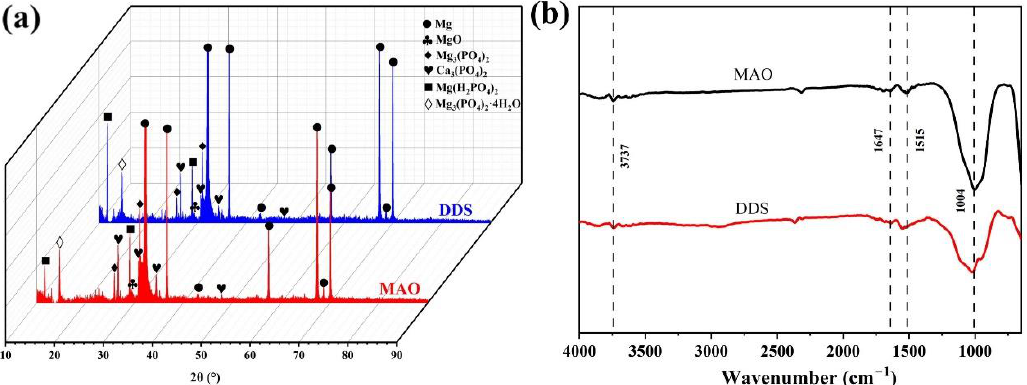
Figure 2. XRD patterns ( a ) and FT-IR ( b ) patterns of Mg-based MAO alloy and Mg-based MAO-MT- PLGA DDS.